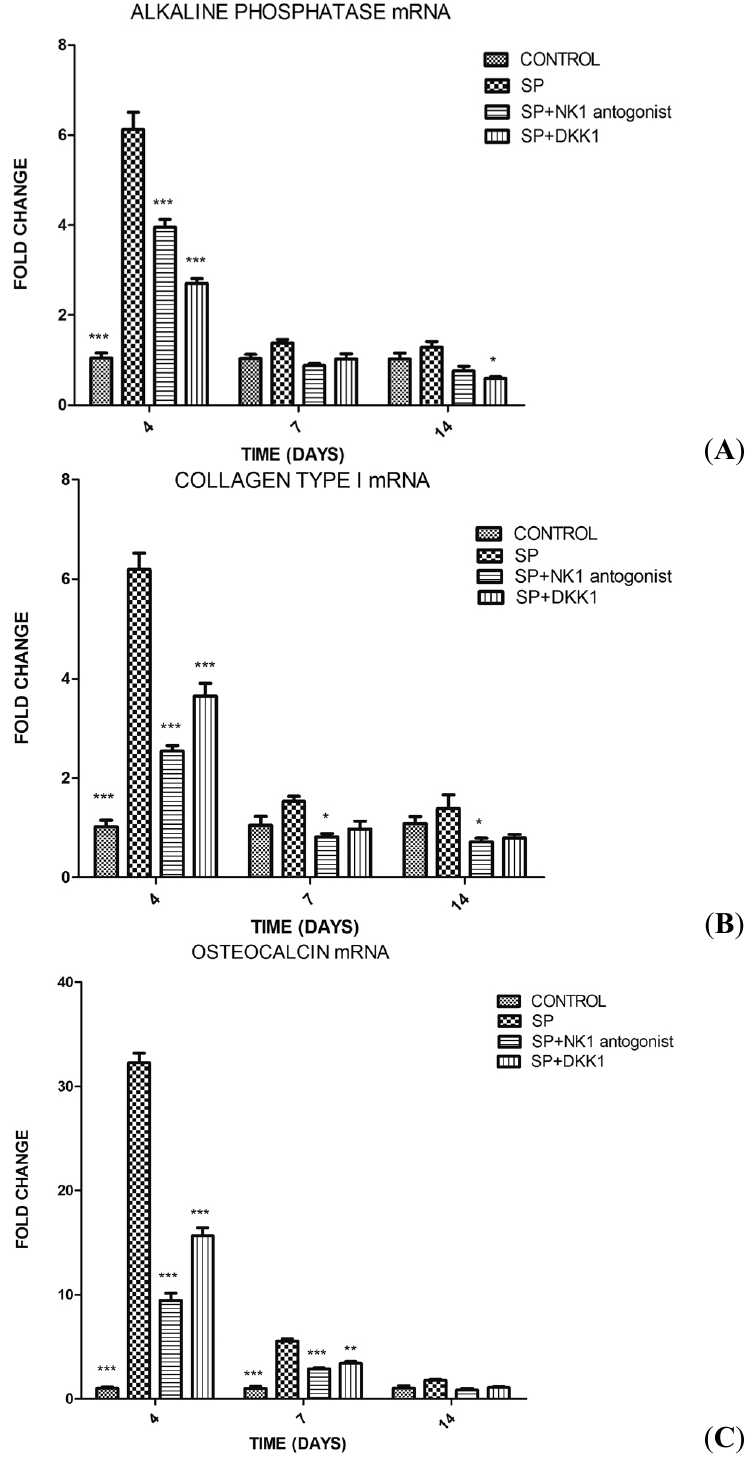
Figure 3. Effects of SP, SP + NK1 (neurokinin-1) antagonist, SP + DKK1 (Dickkopf-1) and the same amount of phosphate-buffered saline (PBS) on days 4, 7, 14 on gene expressions in MC3T3-E1 cells measured by quantitative polymerase chain reaction (qPCR). ( A ) alkaline phosphatase; ( B ) collagen type I; ( C ) osteocalcin; and ( D ) Runx2 mRNA. Results are representative of 3 independent experiments. * p < 0.05 versus SP; ** p < 0.01 versus SP; and *** p < 0.001 versus SP,